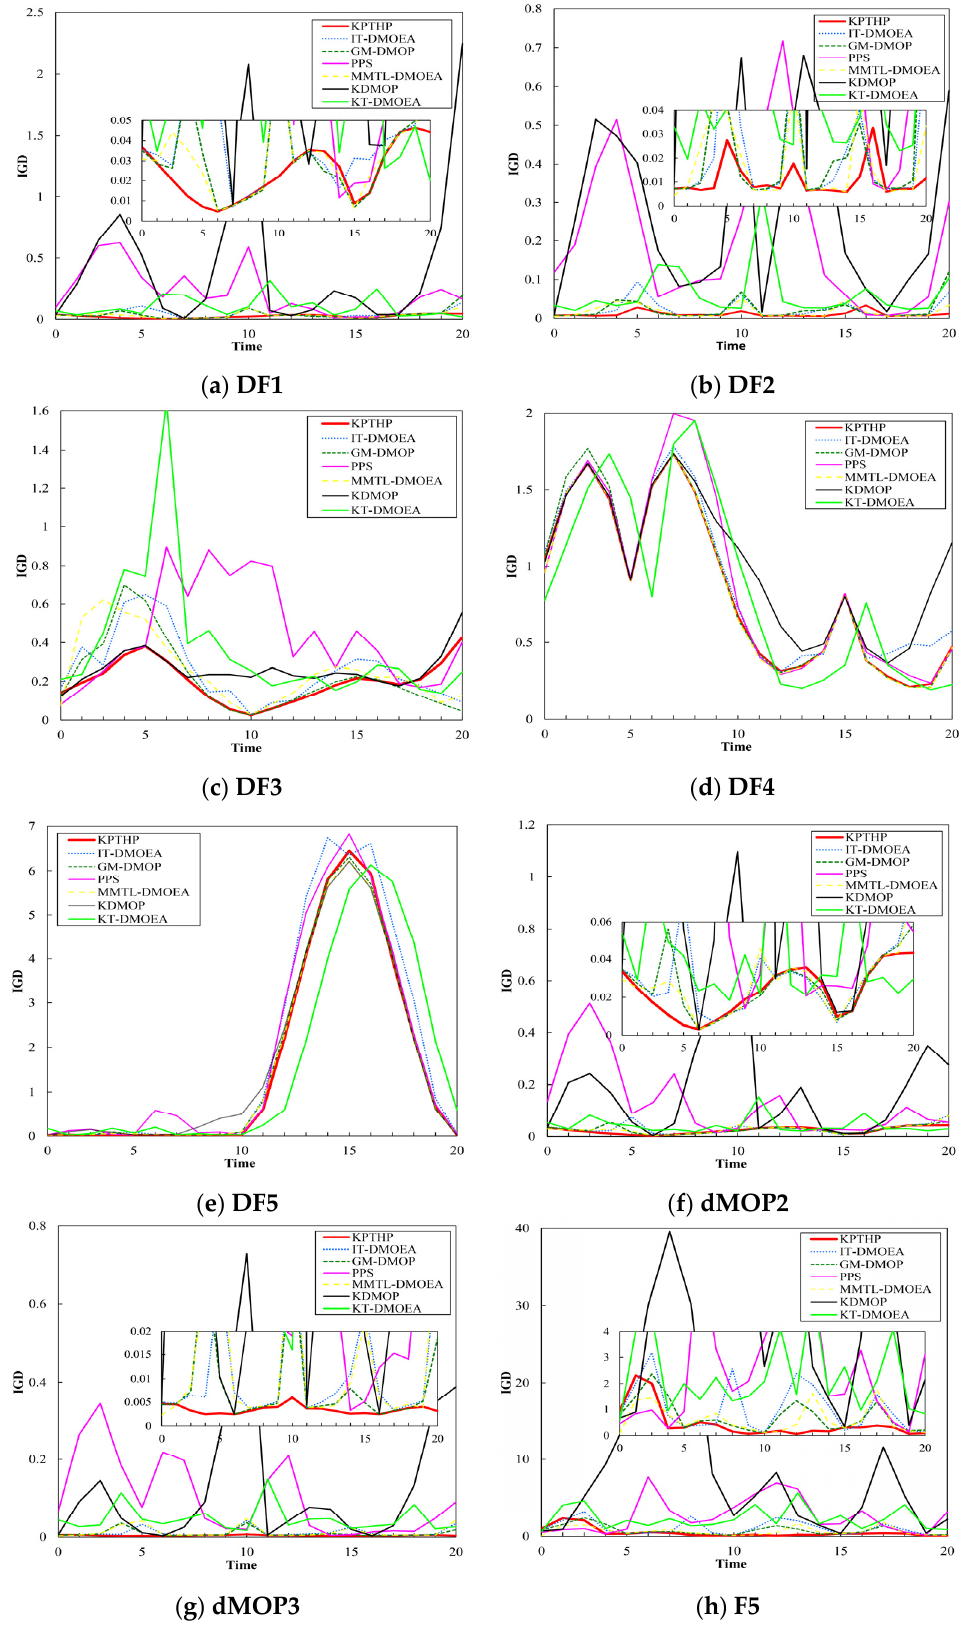
Figure 5. Evolutionary curves of IGD values for eight algorithms with n t = 5 and τ t = 10 on DF1-F5.